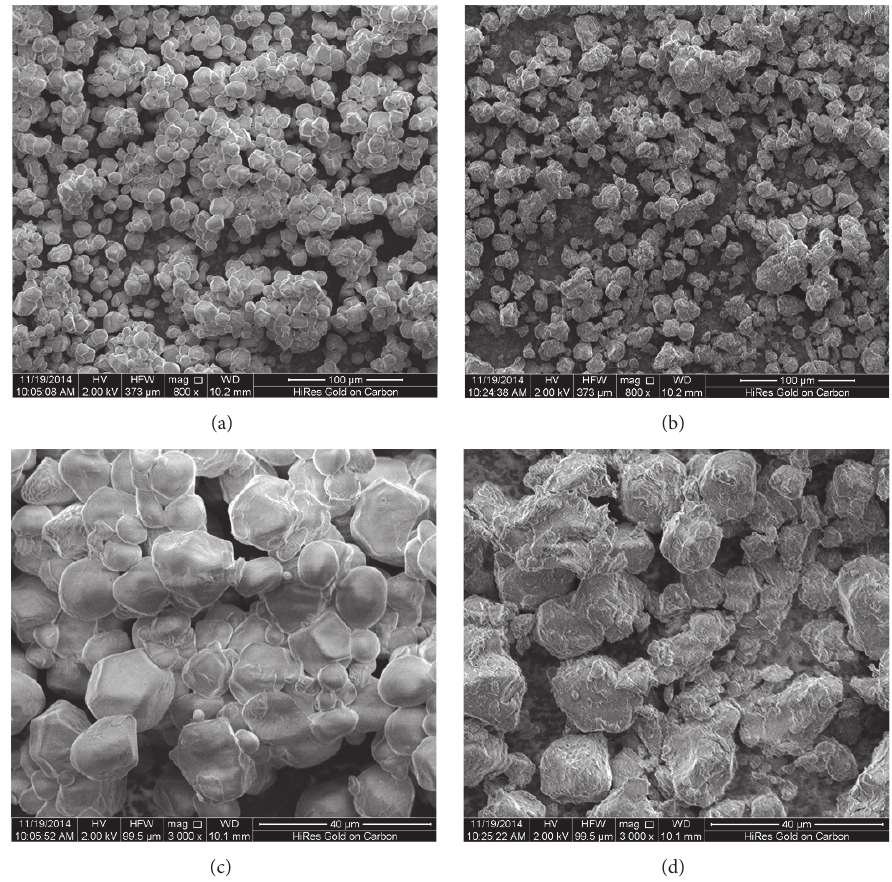
Figure 3: The morphology of DAS (a, c) and HDAS (b,